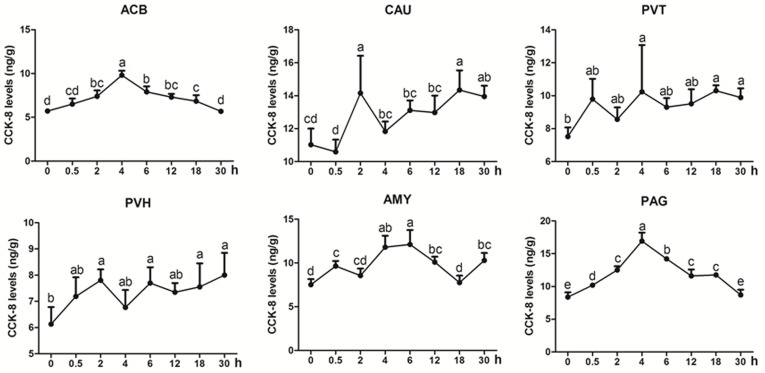
The effect of EA on CCK-8 levels in the CNS of goats (mean ± SD, n = 6). CCK-8 levels in the nucleus accumbens (ACB), the caudate nucleus (CAU), the paraventricular nucleus of the thalamus (PVT), the paraventricular nucleus of the hypothalamus (PVH), the amygdala (AMY), and the periaqueductal gray (PAG). The values with different letters differ significantly (p < 0.05). One-way ANOVA followed by Bonferroni’s post-test.